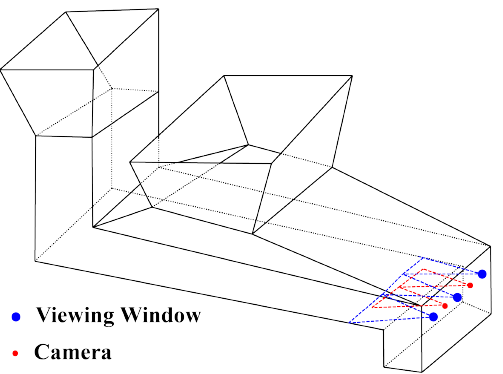
Figure 8. Schematic of the MSW incinerator’s chamber and the positions of viewing windows and